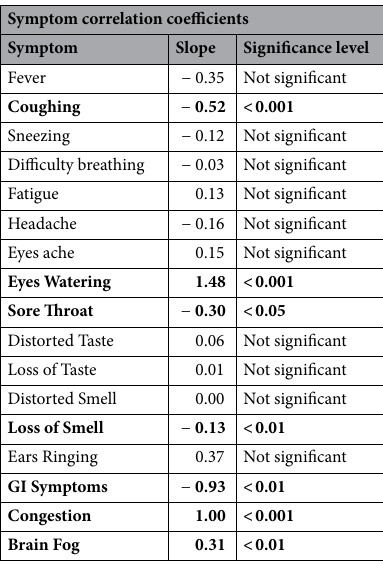
Table 2. Linear correlations between the self-reported symptoms of study participants and measured cycle threshold values. Linear correlations between the self-reported symptoms of study participants and measured cycle threshold values in the environmental samples. The statistical significance of the correlation for each symptom is noted, and the slope indicates the direction of the relationship. Positive values indicate decreased environmental viral load and negative values indicate increased environmental viral load. Significant values are in bold.